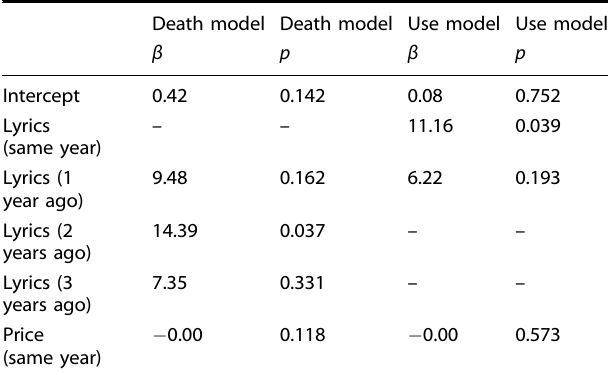
Table 1. Parameter estimates for distributed lag